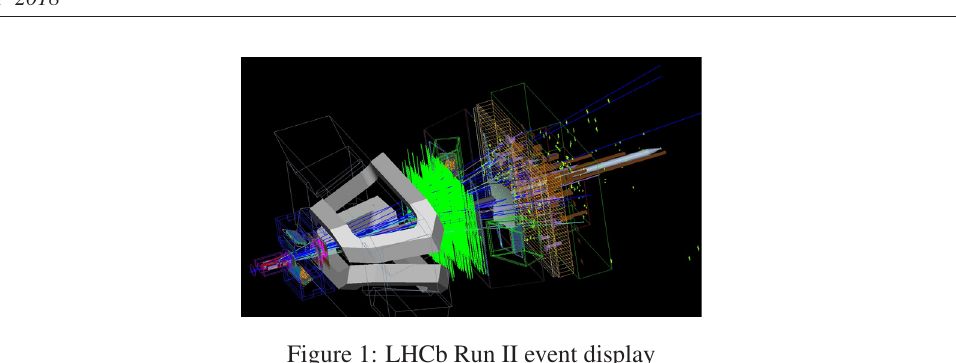
Figure 1: LHCb Run II event display